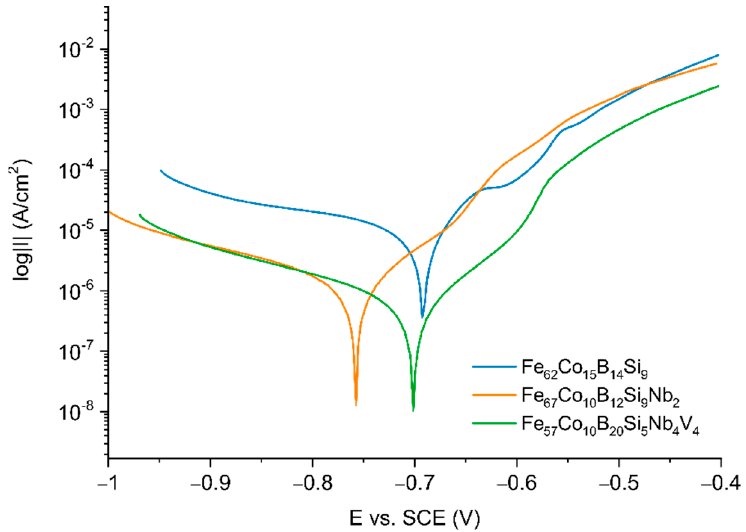
Figure 6. Tafel plots for fabricated alloys.